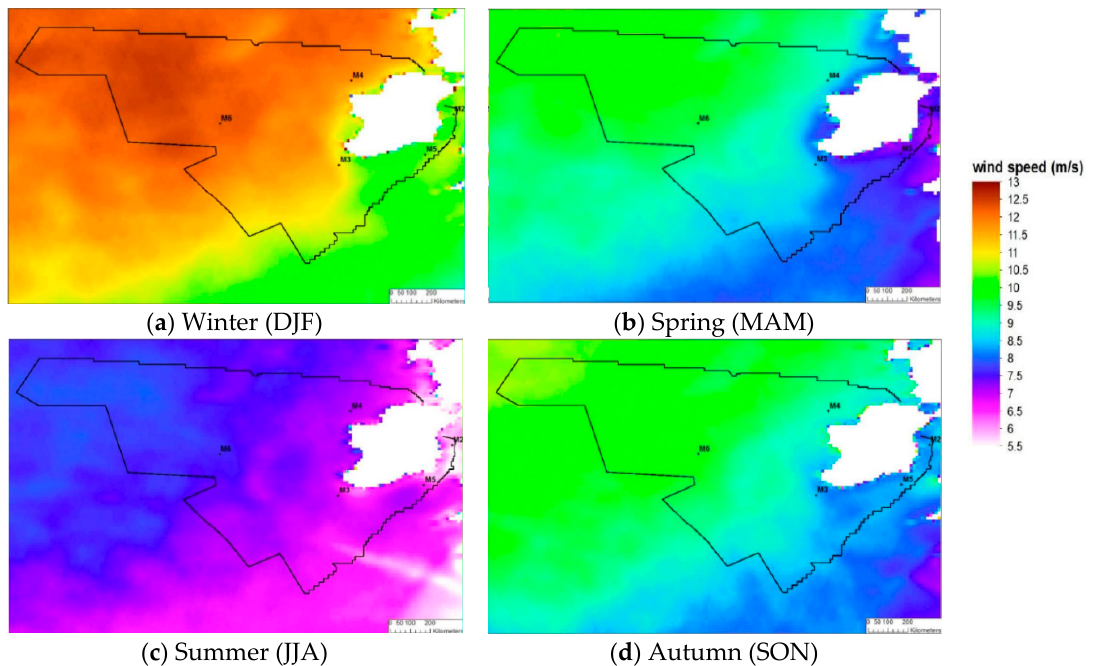
Figure 5. Seasonal offshore wind speed maps (m s − 1 ) from ASCAT-A and ASCAT-B retrieved between January 2012 and May 2017.